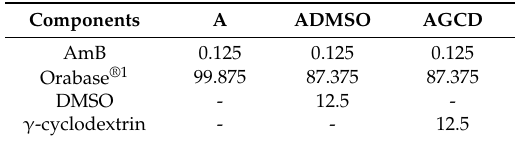
Table 1. Composition (%, w / w ) of the semisolid formulations. Key: A semisolid AmB simple reference formulation, ADMSO is an AmB reference formulation with DMSO, and AGCD is an AmB formulation with γ -cyclodextrins.